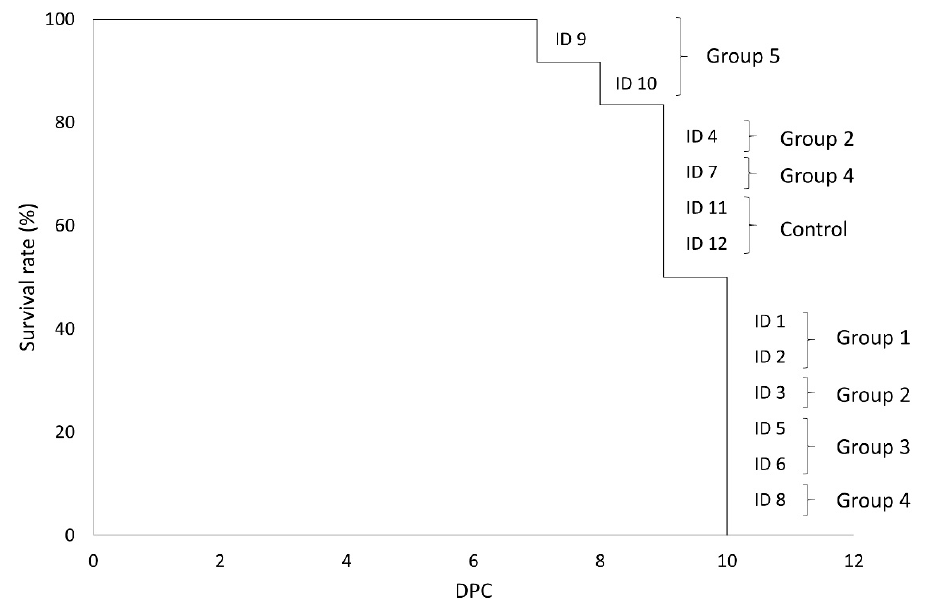
Figure 4. Kaplan–Meier survival curve of vaccinated and control domestic pigs subsequently chal- lenged intramuscularly with the virulent Pol16/DP/OUT21 ASFV. DPC: days post-challenge. During post-mortem evaluation, all the vaccinated and control animals had patho- logical lesions consistent with ASF. All the animals developed splenomegaly, lymphade- nomegaly, hepatomegaly and an accumulation of yellowish to reddish fluid in the ab- dominal cavity (ascites), thorax (hydrothorax), and pericardial sac (hydropericardium; see Figure 5). Other intermittent observed pathological lesions were hemorrhagic lym- phadenitis, congestion in the kidneys, perirenal edema, and hemorrhages in the stomach and intestines.